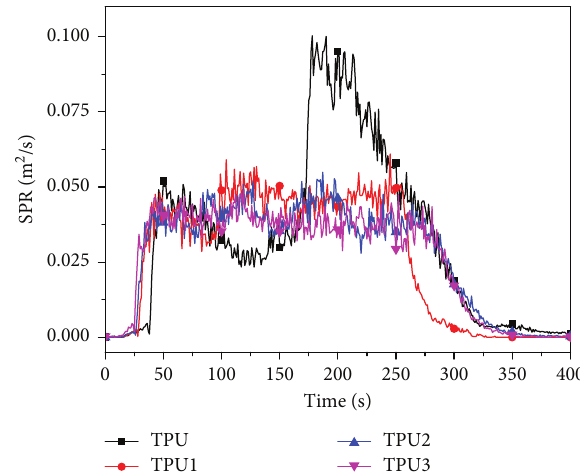
Figure 7: SPR curves of TPU and TPU